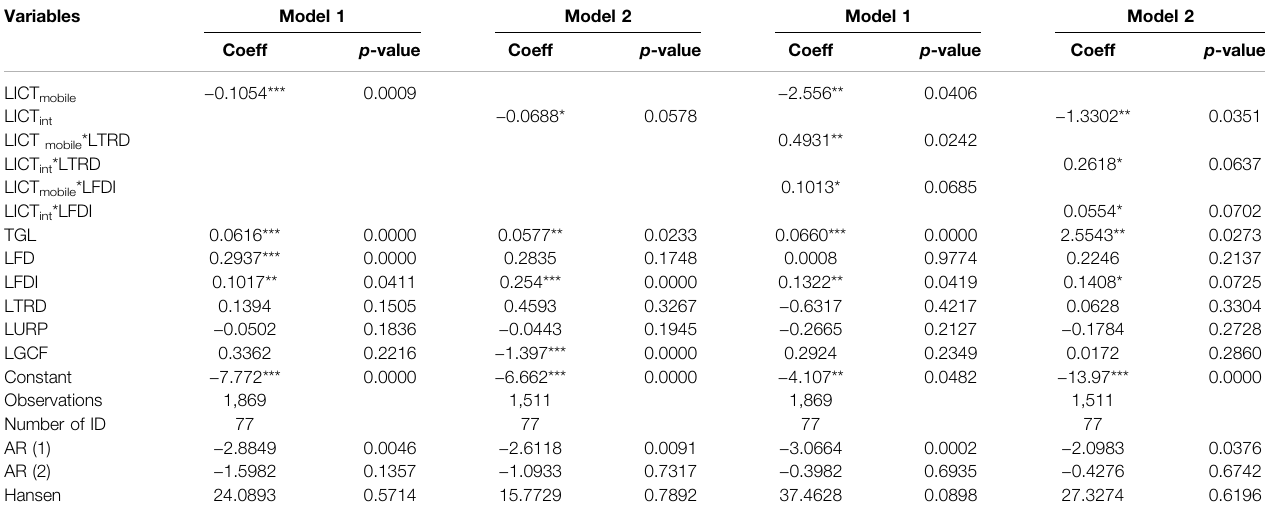
TABLE 7 | Dynamic elasticity evidence (alternative proxy